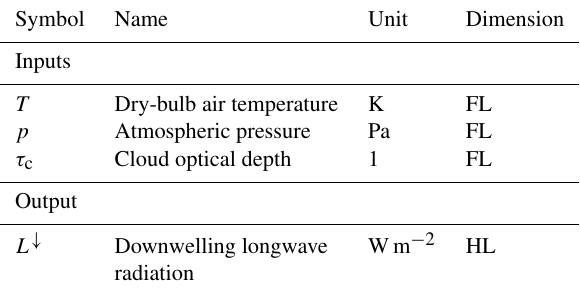
Table 1. Profiles of input and output quantities used in this study. Input quantities are dry-bulb air temperature T , atmospheric tem- perature p , and cloud layer optical depth τ c . T and p are taken directly from the NWP-SAF dataset (Eresmaa and McNally, 2014), and τ c is derived from other quantities as described in Sect. 2.4. The output quantity downwelling longwave radiation L ↓ is com- puted using the physical model described in Sect. 2.4. Atmospheric model levels are 137 for full levels (FLs) and 138 for half-levels